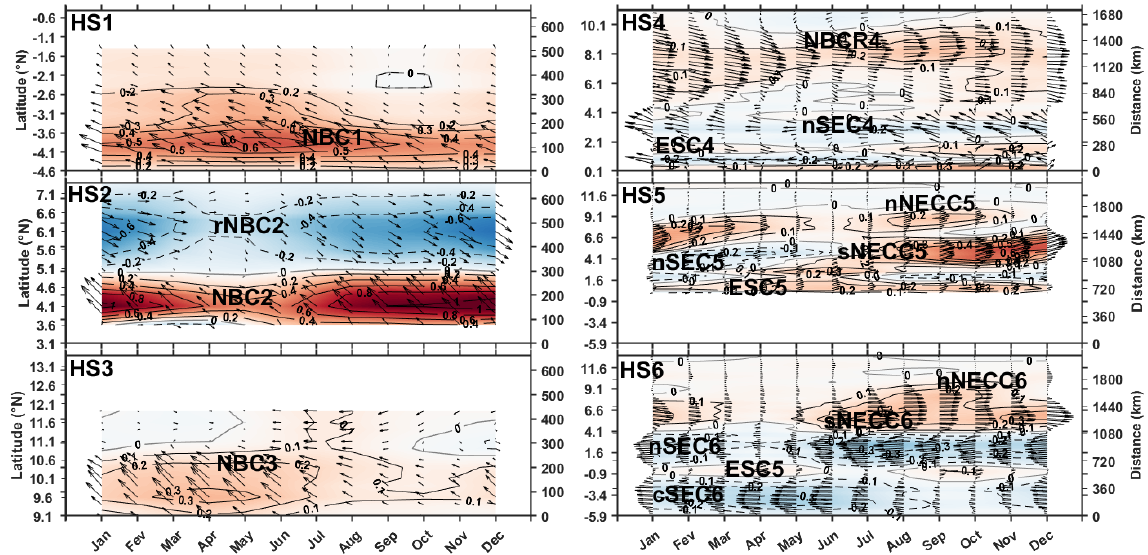
Figure 4. Average seasonal cycle obtained from Fig. 3 (vectors of the currents are superimposed on the contour of their amplitude in ms − 1 ) . The distances from the southernmost point (in km) are indicated on the right-hand y axis of each